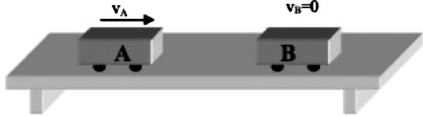
FIG. 2. Cart B is at rest on a table as shown. Cart A approaches cart B from the left and collides with cart B . Immediately after the collision, the two carts separate. Compare the magnitudes and di- rections of the force exerted on cart B by cart A with the force exerted on cart A by cart B while the carts are in